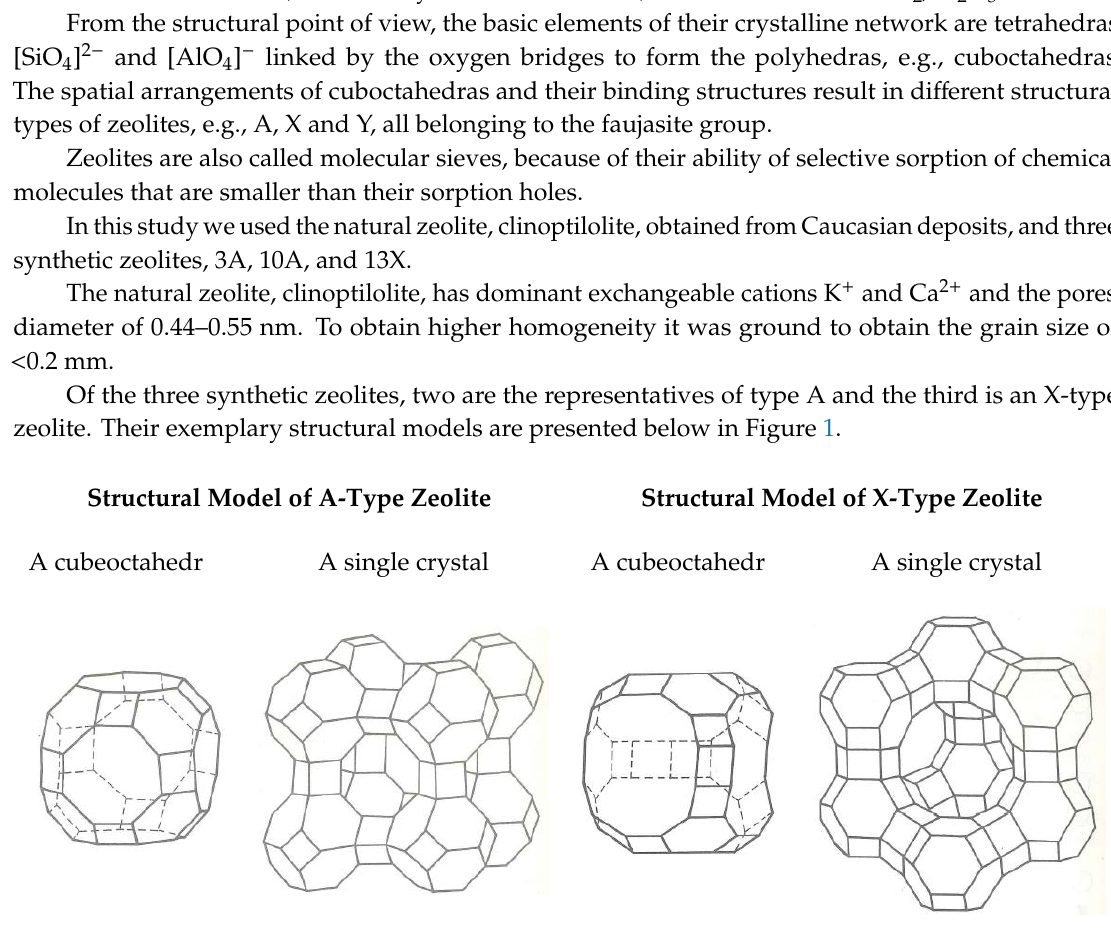
Table 1. The basic properties of each of the minerals used in the experiment. Property